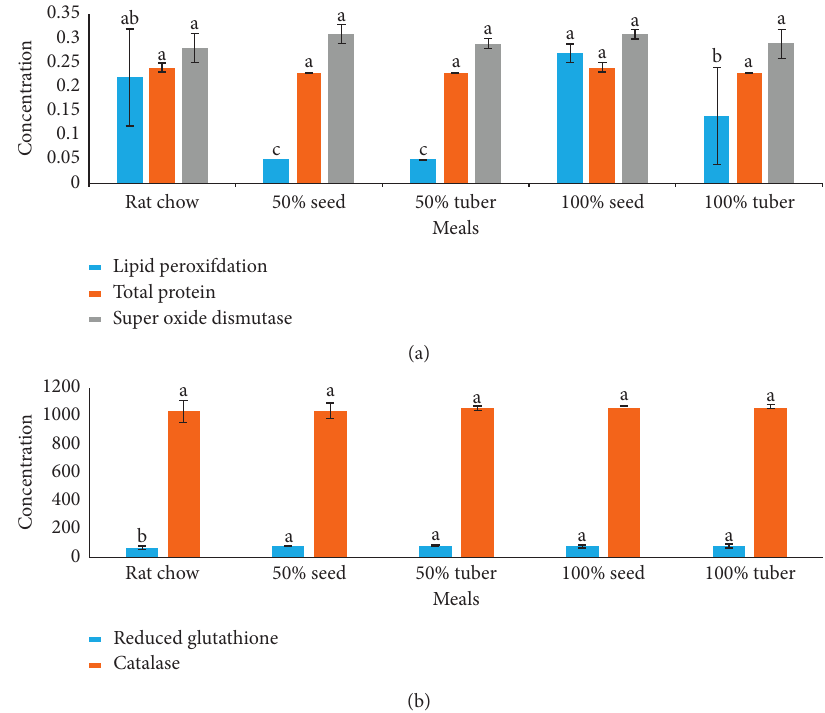
Figure 2: Effect of AYB seed and tuber meals on the levels of (a) lipid peroxidation (LPO), total protein, and superoxide dismutase; (b) reduced glutathione (GSH) and catalase in the kidney of healthy Wistar rats 72h after administration. All values are expressed as Mean ± SD ( n � 6). Means followed by the same letters are not significantly different ( p < 0 . 05). SOD (unit mg − 1 protein), GSH (mmoles min − 1 mg − 1 protein), LPO (unit mg − 1 protein), catalase (mmoles min − 1 mg − 1 protein), total protein (mg − 1 protein).